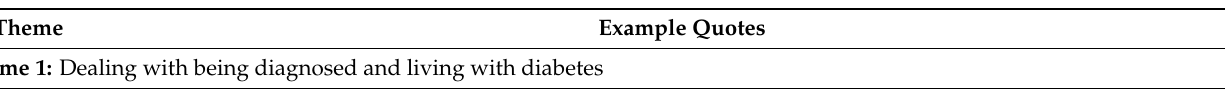
Table 3. Representative quotes describing patient-oriented